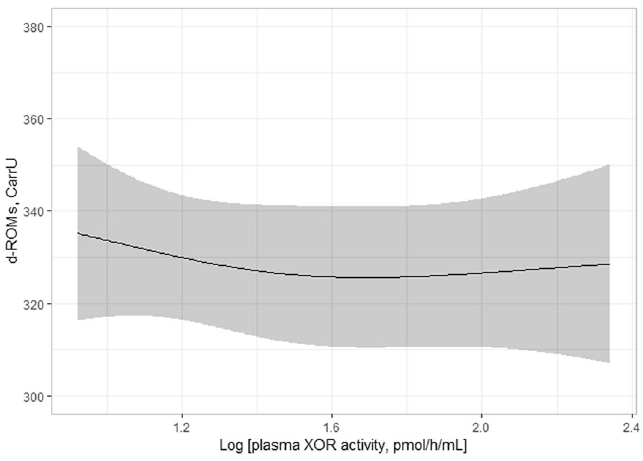
Figure 2. Plasma XOR activity and d-ROMs level. Plasma XOR activity was not significantly associated with d-ROMs level ( p = 0.725). Best fitted line and 95% CI results are shown by a solid line and gray band, respectively. Values for d-ROMs were adjusted according to the median values for age, gender, smoking habit, alcohol drinking habit, VFA, SBP, total cholesterol, HbA1c, eGFR, log HOMA-IR, log hs-CRP, and uric acid level. XOR xanthine oxidoreductase, d-ROMs derivative of reactive oxygen metabolites, CI confidence interval, VFA visceral fat area, SBP systolic blood pressure, HbA1c glycated hemoglobin, eGFR estimated glomerular filtration rate, HOMA-IR homeostatic model assessment of insulin resistance, hs-CRP high-sensitivity C-reactive